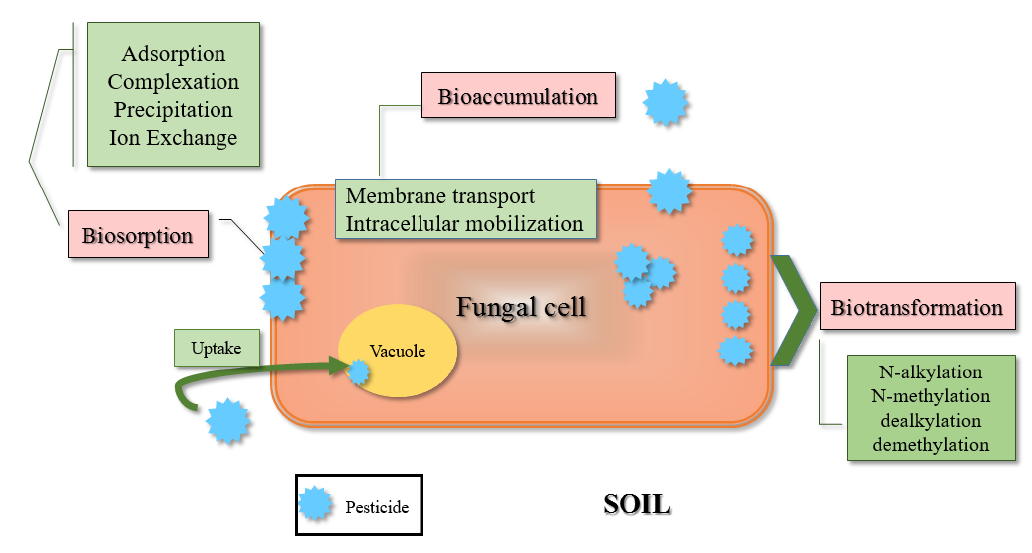
Figure 4: Possible interactions of pesticide with a fungal cell in soil.